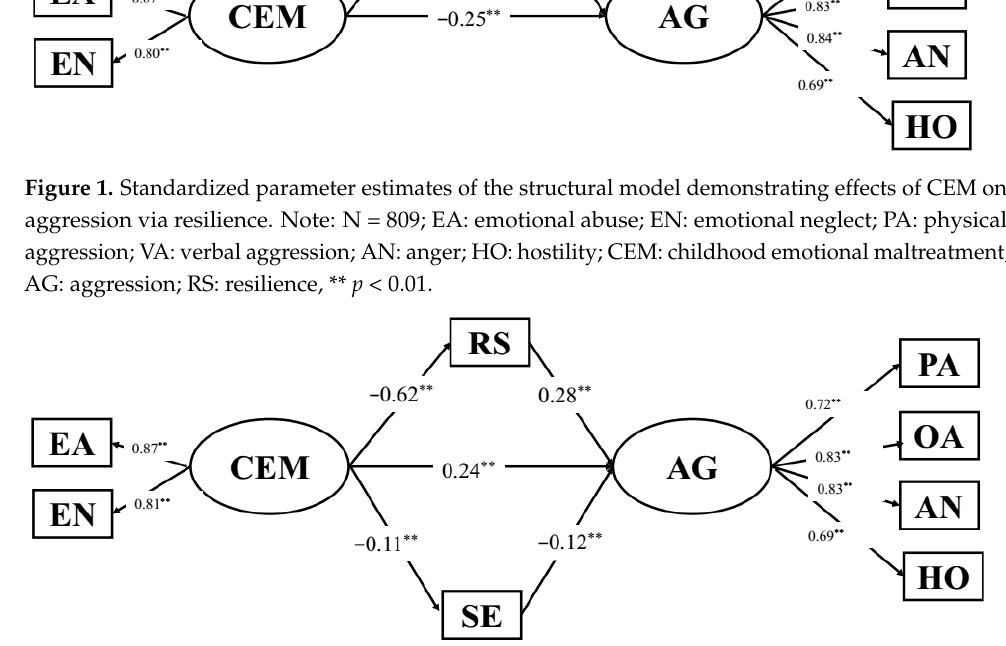
Figure 2. Standardized parameter estimates of the structural model demonstrating effects of CEM on aggression via resilience and self-esteem. Note: N = 809; EA: emotional abuse; EN: emotional neglect; PA: physical aggression; VA: verbal aggression; AN: anger; HO: hostility; CEM: childhood emotional maltreatment; AG: aggression; RS: resilience; SE: self-esteem, ** p < 0.01.